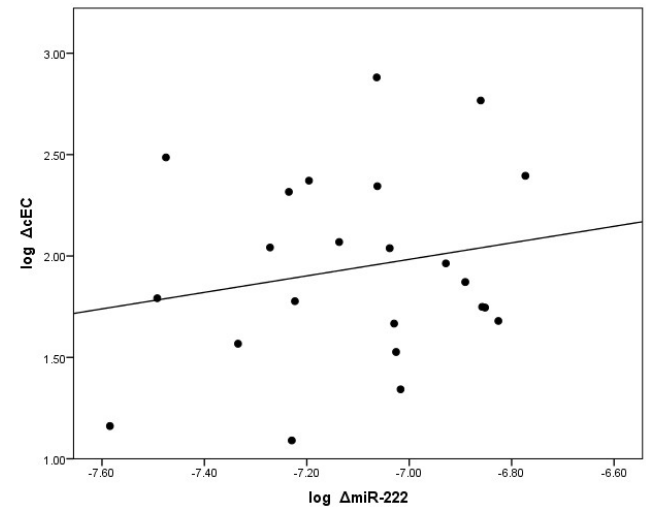
Figure 4. A direct correlation between the change (log delta) in levels of circulating miR‐222 and the change (log delta) of circulating endothelial cells (cECs). cECs are defined by FACS as CD45 dim , CD34 + , CD 133 − , CD144 + and delta cECs, an index of vascular damage. This relationship was demonstrated by Pearson correlation.